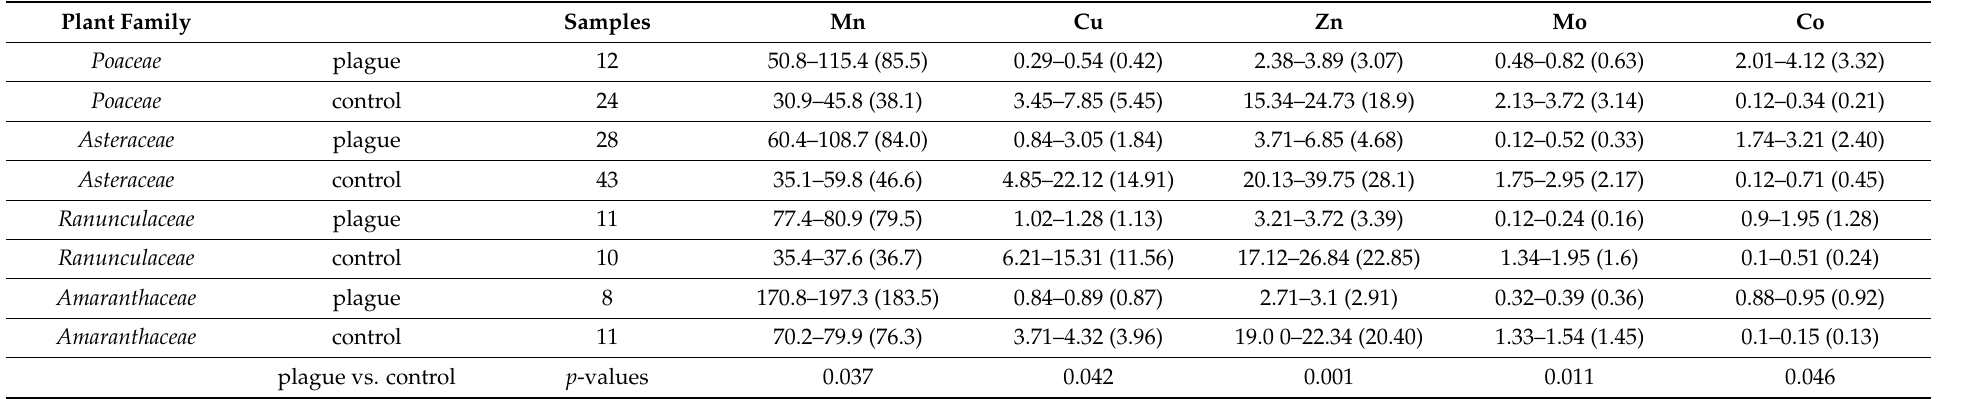
Table 1. Concentration of trace metals (mg/g dry sample weight; range and mean) in plants col-lected within plots with plague epidemics in little susliks ( Spermophilus pygmaeus ) and in neigh-boring control plots in the Caspian Depression, Kazakhstan, in 1979 (modified from Zhulidov et al., 1981 [35]). p -values were derived from repeated-measures comparisons of plague and control mean concentrations with plant families as